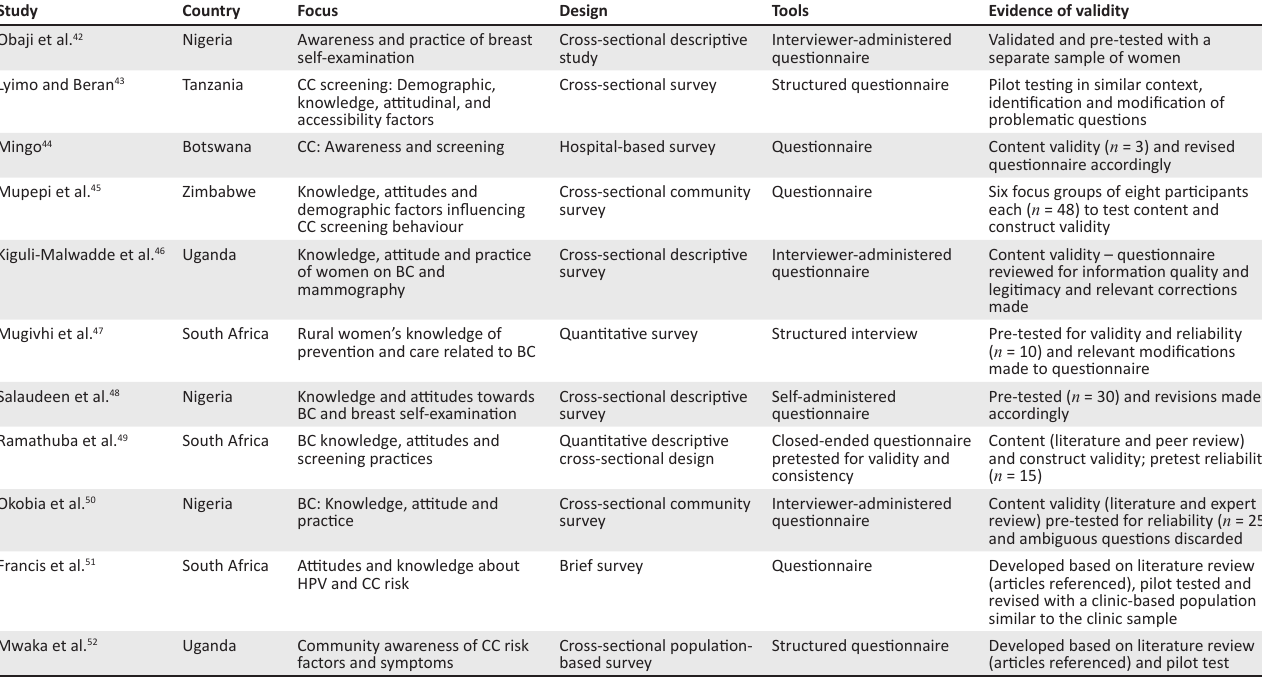
TABLE 2 (Continues...): Symptom awareness tools identified, some validation details provided.